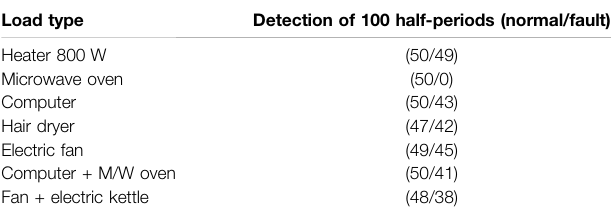
TABLE 1 | Statistics of arc fault detection results ( d 1 ).